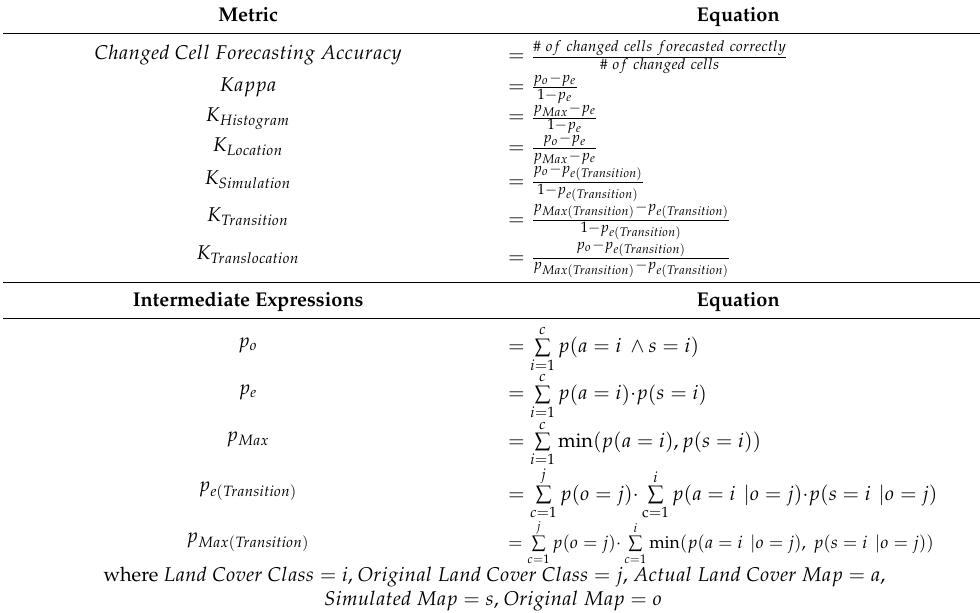
Table 1. Metrics used in this study to determine how well the method forecasts Land Cover (LC) changes. Kappa metrics have been obtained from [77], where further details regarding these equations can be